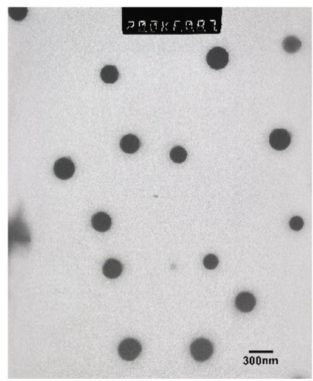
Figure 3. TEM image of dried nanoMIPs synthesized for native